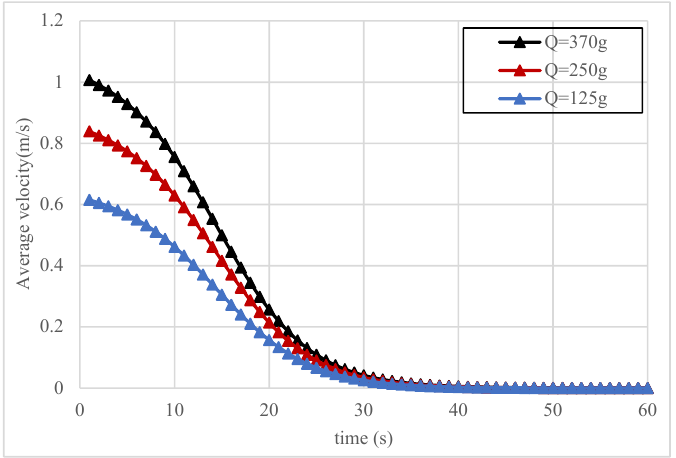
Figure 18. Variation curve of slurry velocity along z-axis at different times.